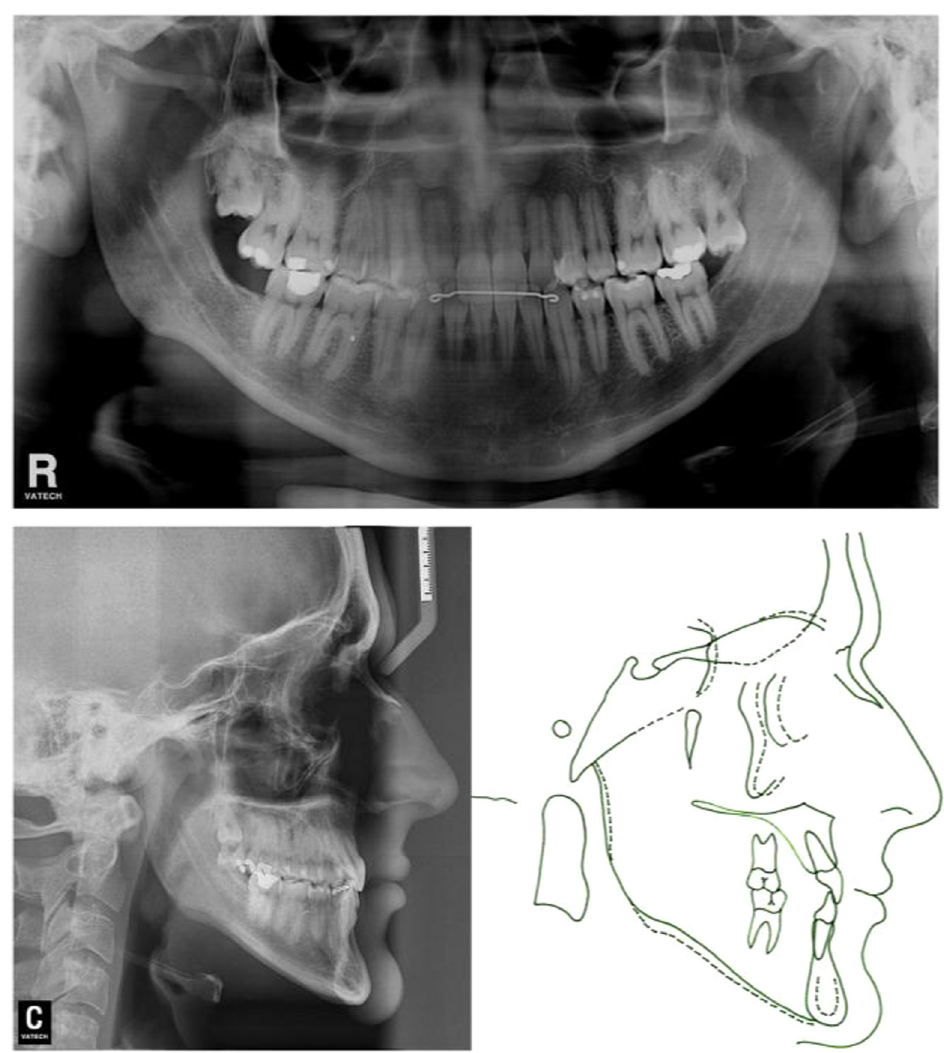
Figure 7. Records after 5 year of